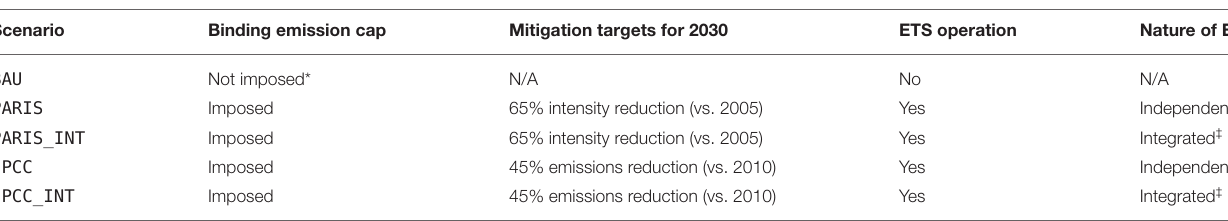
TABLE 3 | Scenarios for model